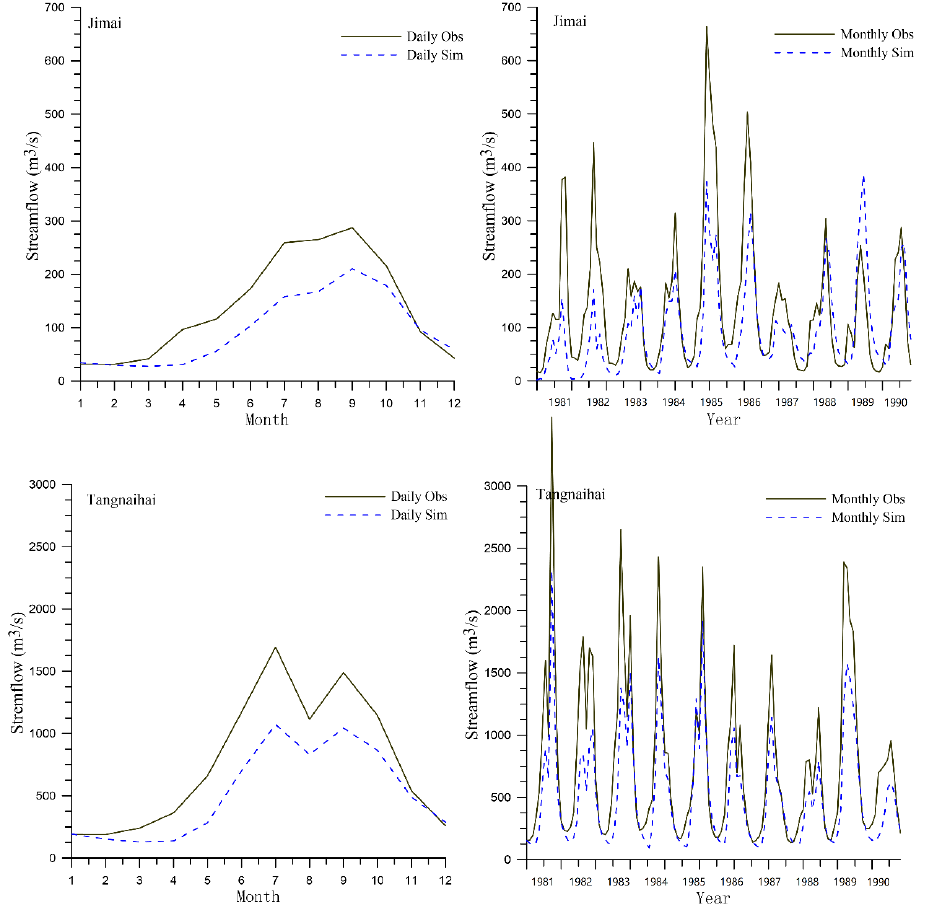
Figure 3. Simulated (sim) and observed (obs) streamflow for the three sub-basins of TRHR during the validation period (1981–1990). Table 3. NSE and D during the calibration and validation periods in VIC simulation in TRHR.